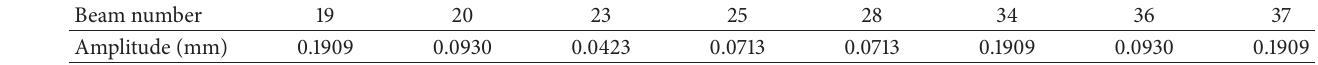
Table 4: 𝑦 -direction maximum amplitude of beams in 𝑁 𝑏 .